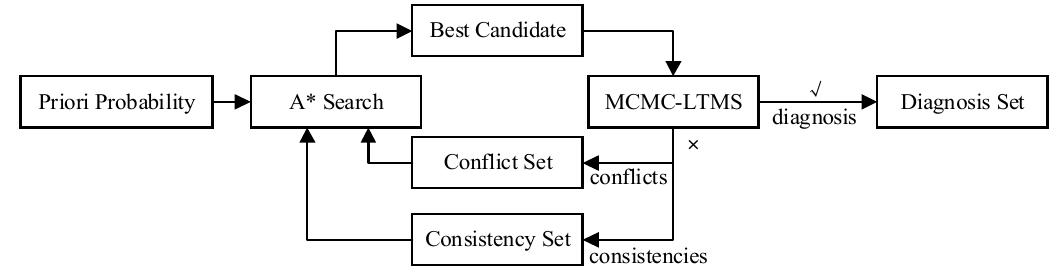
Figure 5. Framework of Conflict and Consistency Directed A* (CCDA).